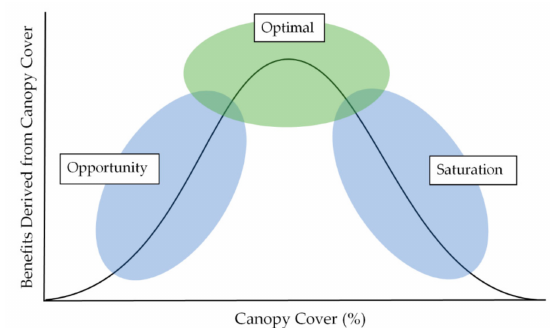
Figure 1. Relationship between canopy cover benefits and percentage of canopy